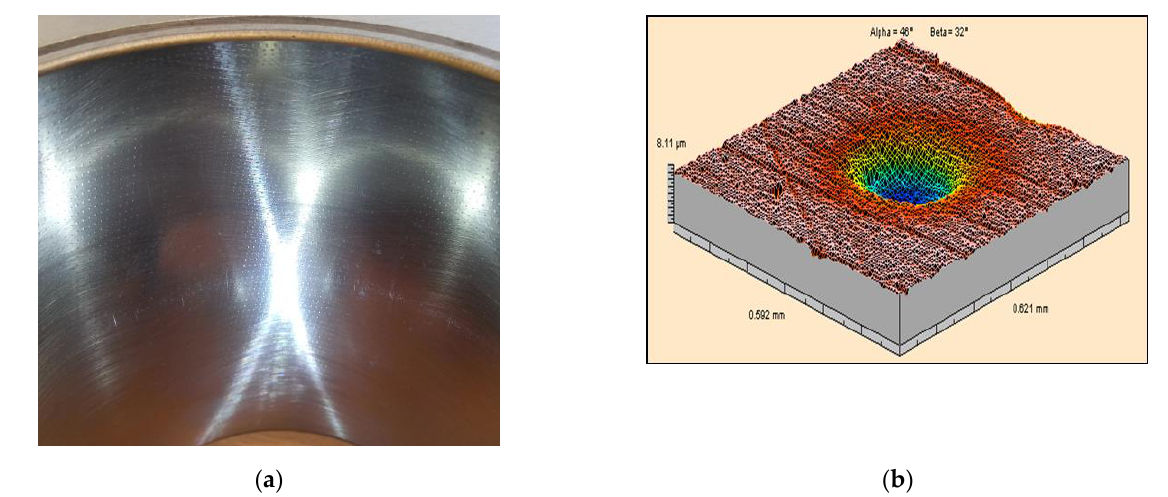
Figure 2. View of Nikasil cylinder liner ( a ) and topography of the single dimple ( b ).